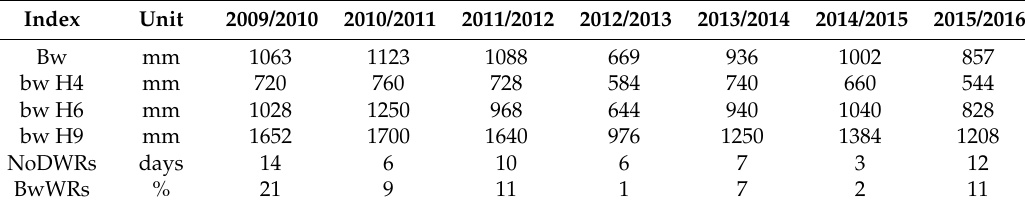
Table 3. Winter mass balance (Bw) for Hansbreen, point mass balance (bw) for H4, H6, and contribution (%) of winter rainfalls to winter mass balance in